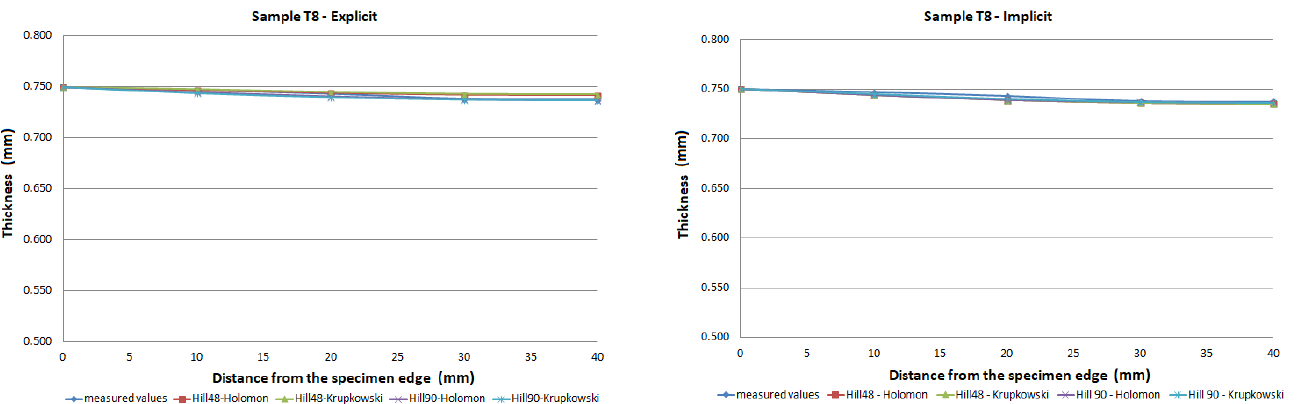
Figure 18. Comparison of predicted and measured thickness values of sample T7 using different types of yield criteria, hardening laws and integration scheme.